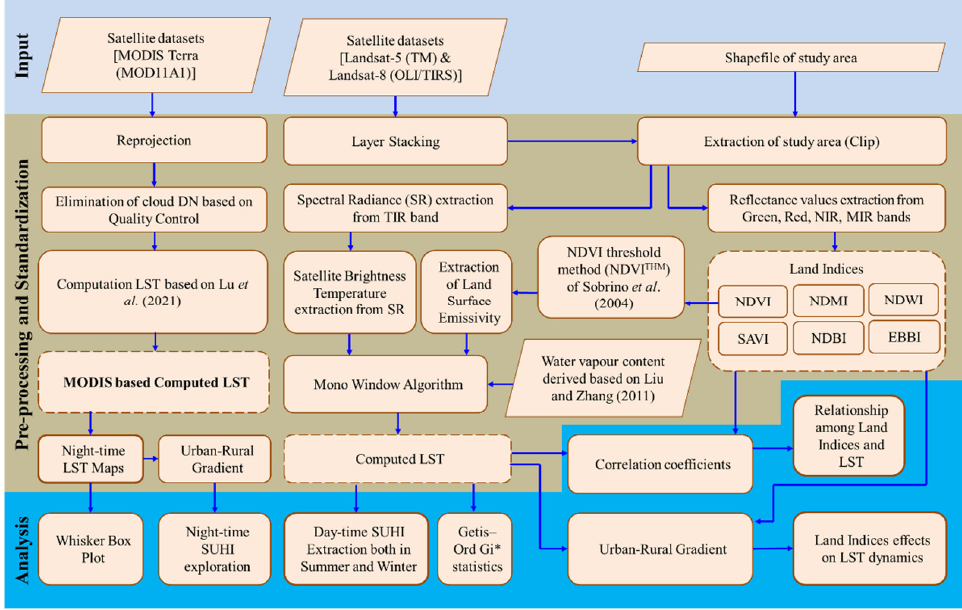
Figure 2. Overall framework of the present research procedure [23,45,46].